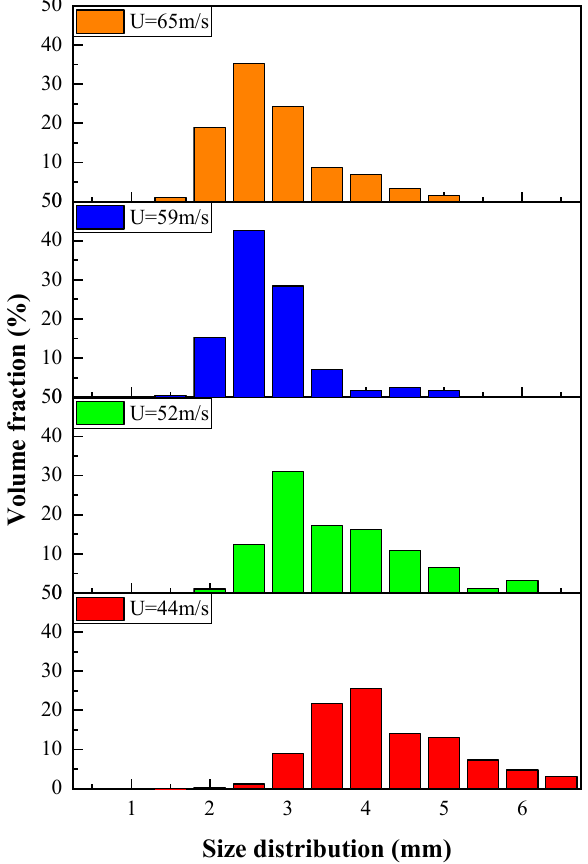
Figure 3. The volume fraction of the emulsified droplets of different sizes.